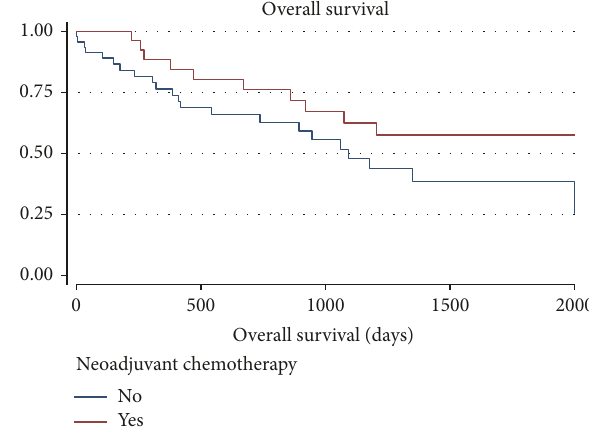
Figure 1: NACT versus no NACT HR − 1.00 no NACT; 0.56 NACT; 95% CI 0.26–1.18. p = 0.128.